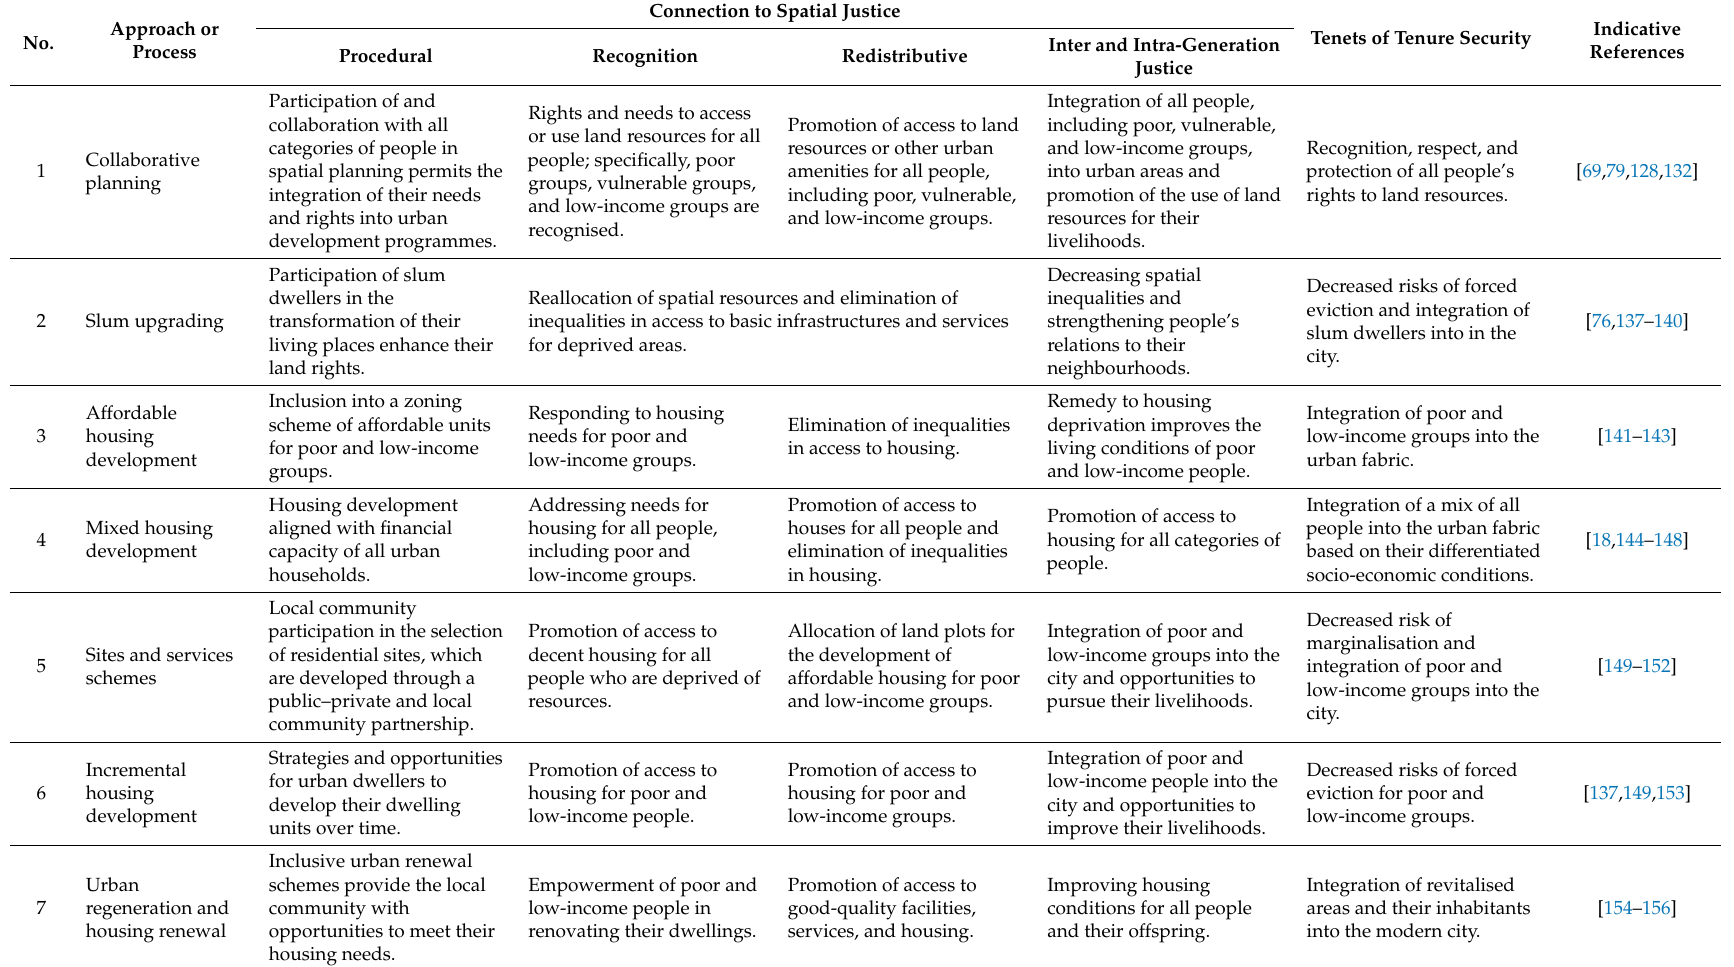
Table 2. Connecting spatial justice to selected urban (re)development approaches and